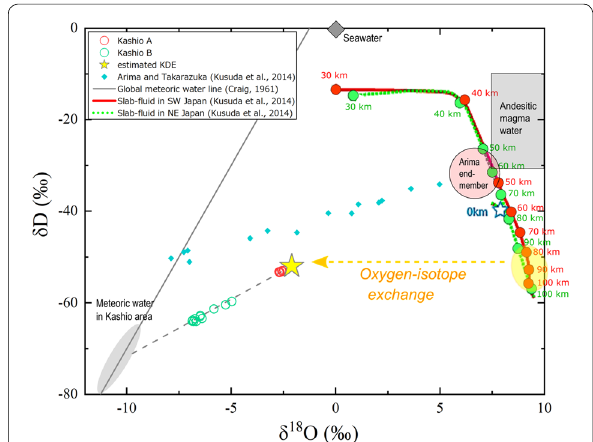
Fig. 9 Comparison of the isotopic compositions of KDE and those of the Arima and Takarazuka waters with the calculated, slab-derived fluid from previous research. Red and green solid lines show the calculation results of δD and δ 18 O in water dehydrated from a subducted slab as a function of depth for the Philippine Sea and Pacific slabs, respectively (Kusuda et al. 2014). The estimated KDE might be interpreted as a slab-derived fluid which originated from dehydration at 80–100 km in depth of the Philippine Sea slab (SW Japan, red solid curve) and its isotope exchange reactions (mainly oxygen) with minerals (yellow arrow). Andesitic magma water and Arima end-member is from Giggenbach (1992) and Kusuda et al. (2014),